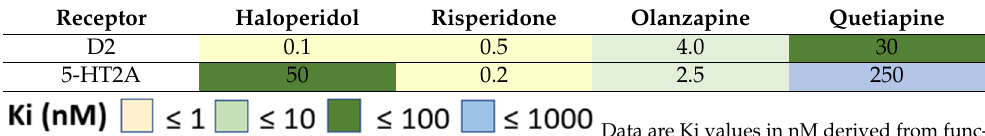
Table 3. Receptor selectivity of antipsychotic drugs.